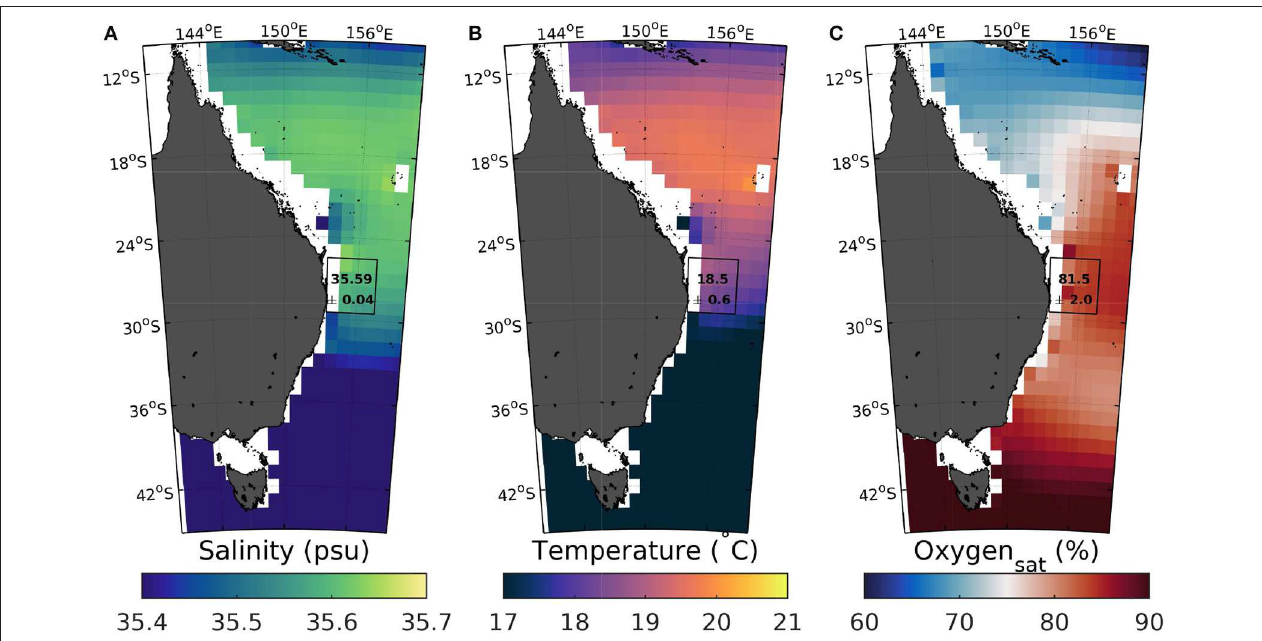
FIGURE 4 | Salinity, temperature, and oxygen saturation climatologies in 200–250 m depth. Mean (200–250 m depth) annual World Ocean Atlas 2009 climatologies of salinity (A) , temperature (B) , and oxygen saturation (C) off the Australian east coast (Antonov et al., 2010; Garcia et al., 2010; Locarnini et al., 2010). Numbers in black squares denote the respective 4 × 4 grid point averages and standard deviations (between 25.5–29.5 ◦ S and 153.5–157.5 ◦ E).